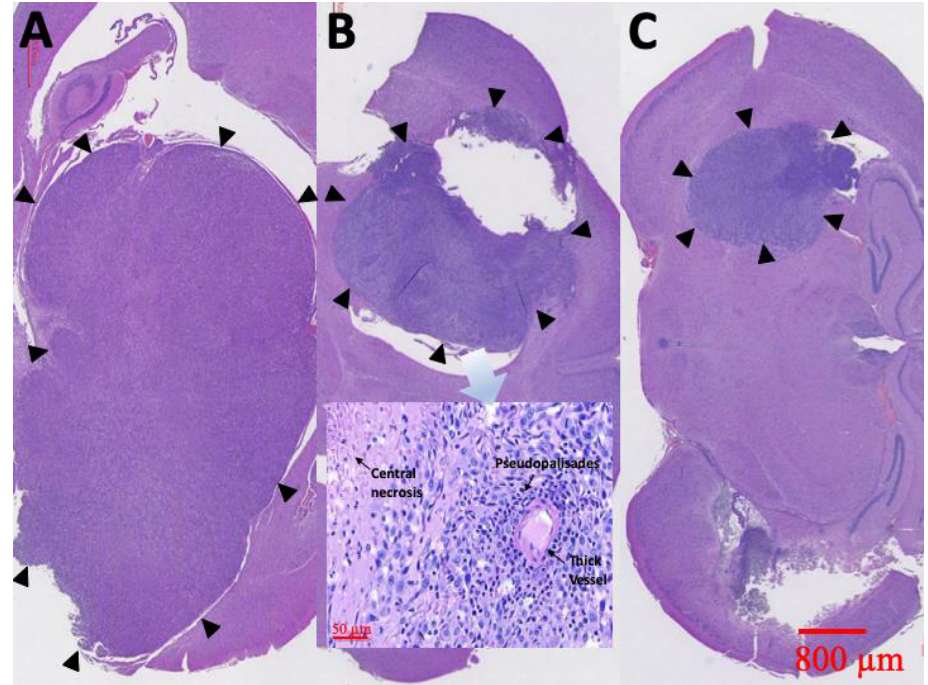
Figure 10. H&E staining. Diffuse karyorrhectic tumor cells with central necrosis were observed in groups A and B. The tumor area and central necrosis were much greater in group A than in group B. Small tumor area and less central necrosis were observed in group C (the tumor edges are indicated by black triangles).